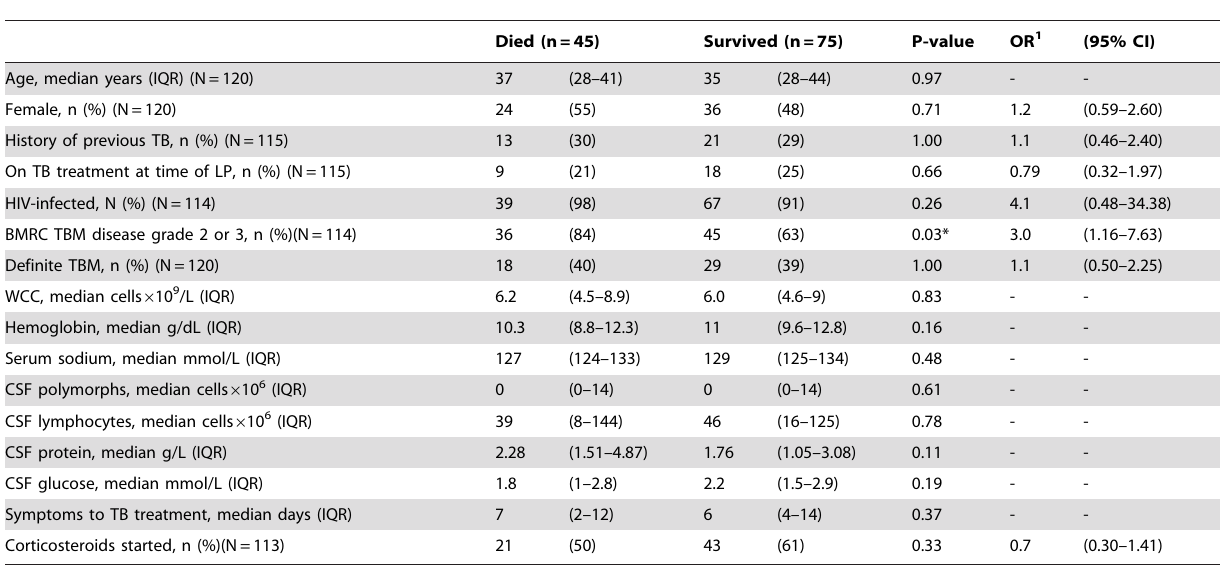
Table 4. Univariate analysis of variables associated with inpatient mortality in all patients with definite, probable and possible tuberculous meningitis (n=120).